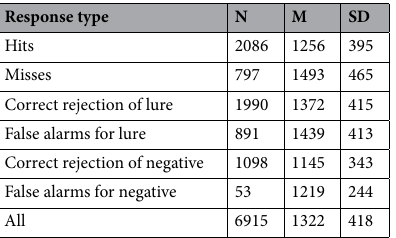
Table 2. Mean reactions times for six response types. M mean, SD standard deviation, N number of